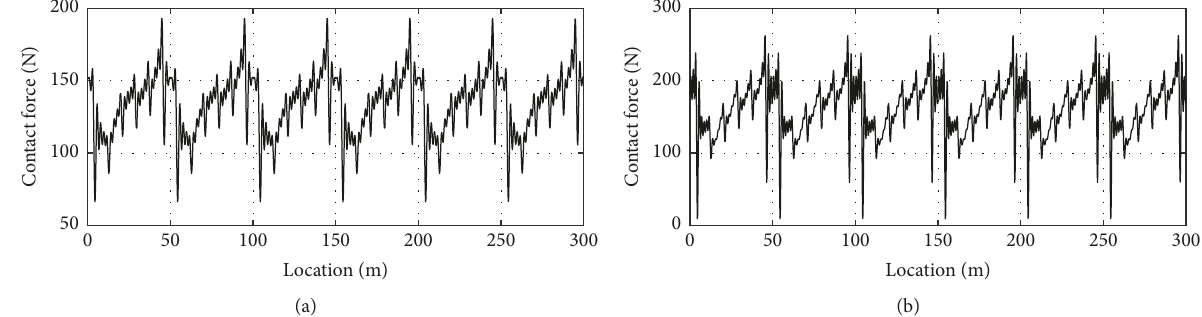
Figure 16: The variation of contact forces for the simple stitched catenary when (a) 𝑉 = 250 km/h and (b) 𝑉 = 300 km/h.